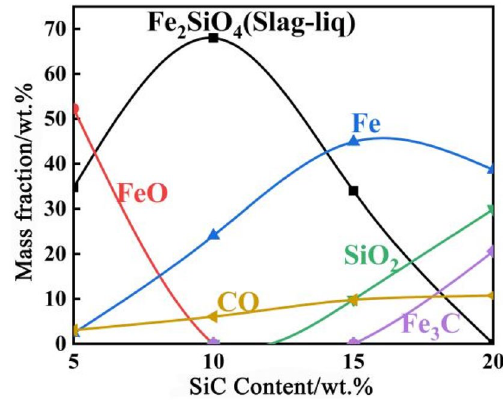
Fig. 3 Mass fraction of each phase in equilibrium state with differ- ent SiC content